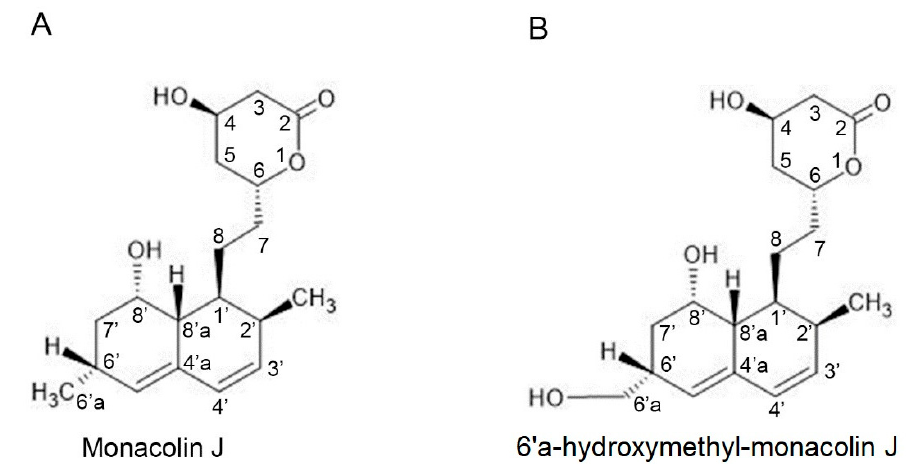
Figure 1. Chemical structures of monacolin J and 6 ′ a-hydroxymethyl monacolin J. ( A ) Chemical structure of monacolin J. ( B ) Chemical structure of a major product from monacolin J that was catalyzed using CYP102A1 in the presence of NADPH. The structure of the product was found to have an OH group attached to the C-6 ′ a position, while the original monacolin J structure had an H 3 group.